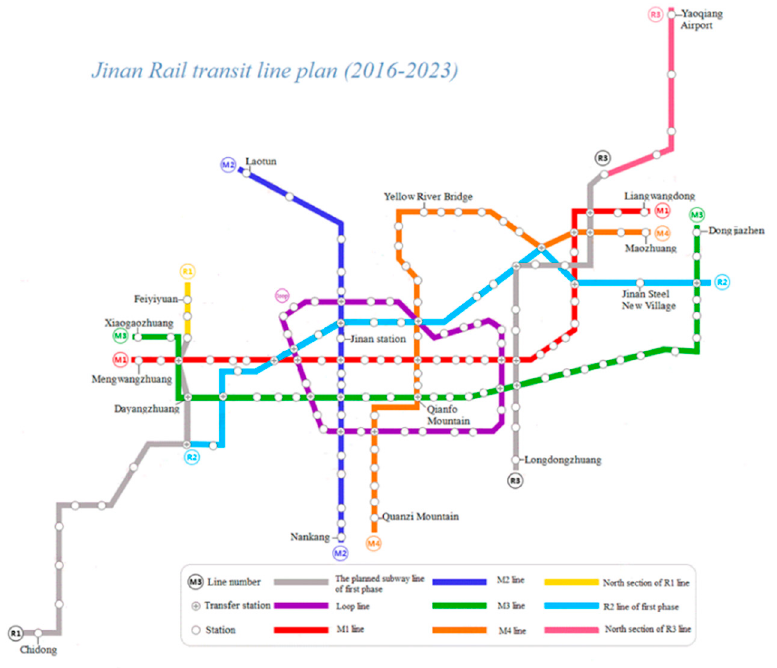
Figure 6. The planning map of the rail transit line in Jinan [29].